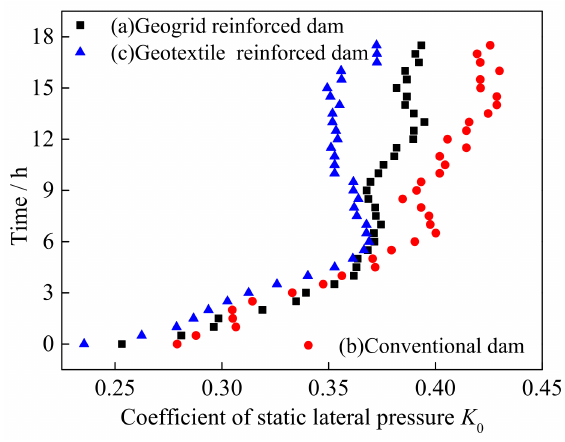
Figure 10. Relationship between the static-side pressure coefficient and time.